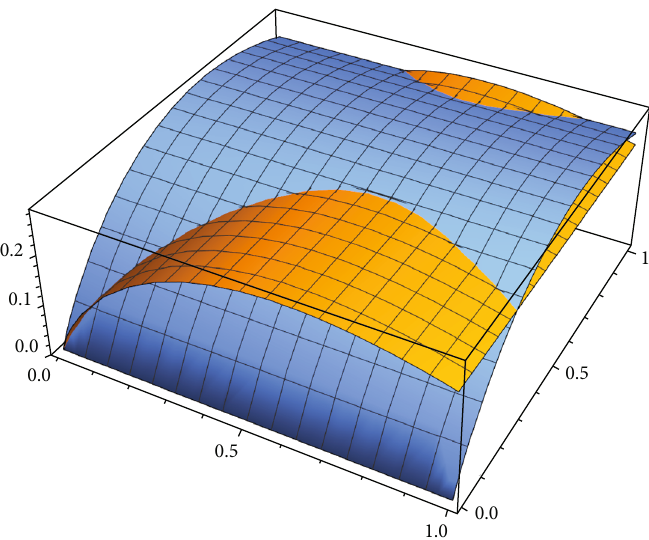
Figure 2: Simulations of the solution for α = 0 : 8 and α = 0 : 9